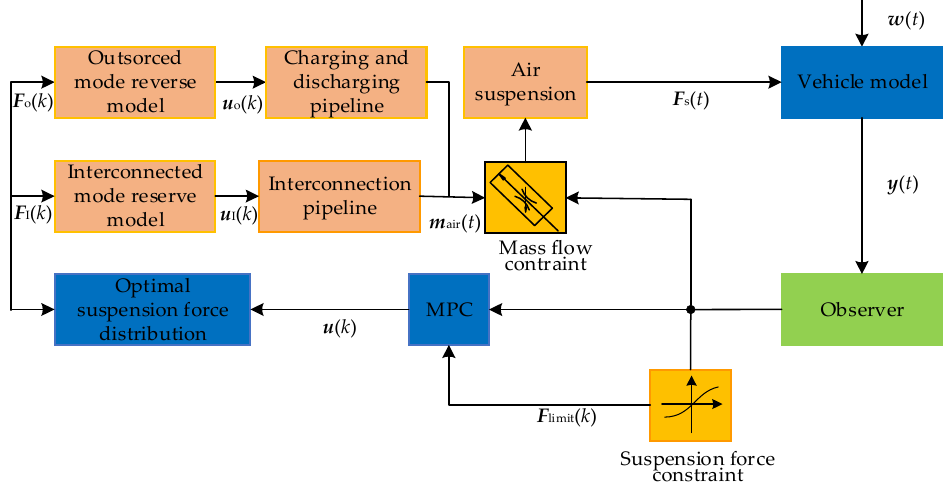
Figure 3. Cooperative control flow chart of interconnected air suspension.